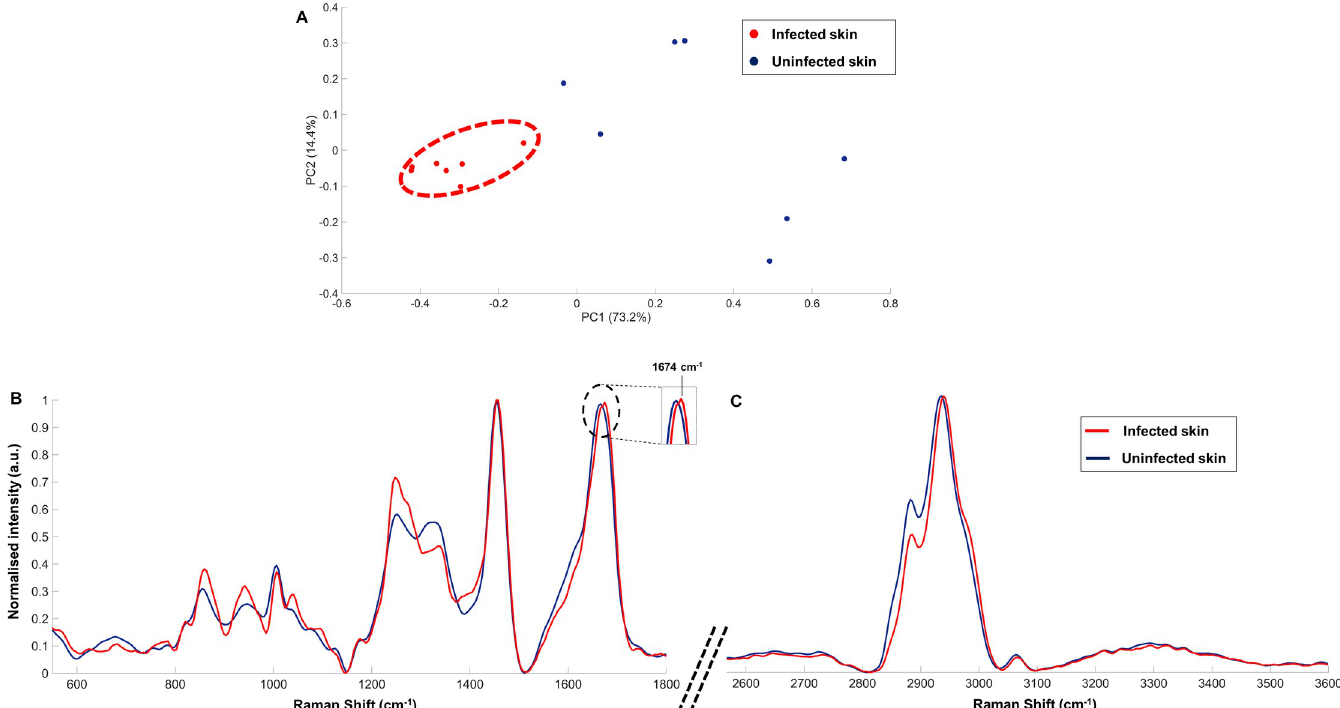
Fig 2. Raman analysis of T . b . brucei infected (red) and uninfected (blue) murine skin sections (BALB/C) on CaF 2 slides showing (A) the resulting PCA scores plot, and their associated averaged normalised Raman spectra in the spectral window (B) 550–1800 cm -1 and (C) 2550–3600 cm -1 . Raman maps measurements were taken using a 532 nm excitation laser and 1 s acquisition time over a 50 x 50 μ m square on the skin for each map and 2 μ m step across x and y. Spectra were obtained by averaging seven maps from each tissue sample, then normalised to the highest peak intensity. Tentative peak assignment is given in Table 2.